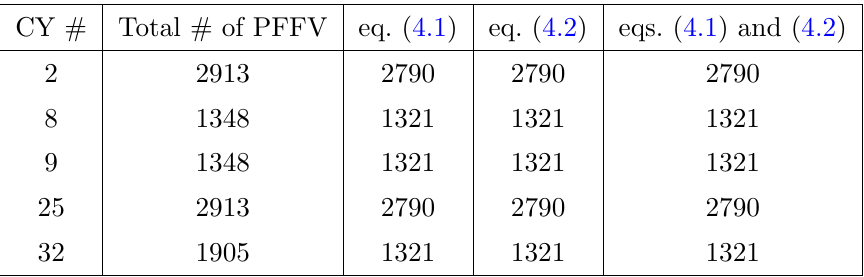
Table 4. Detailed list of total number of PFFV satisfying eq. (4.1) or eq.